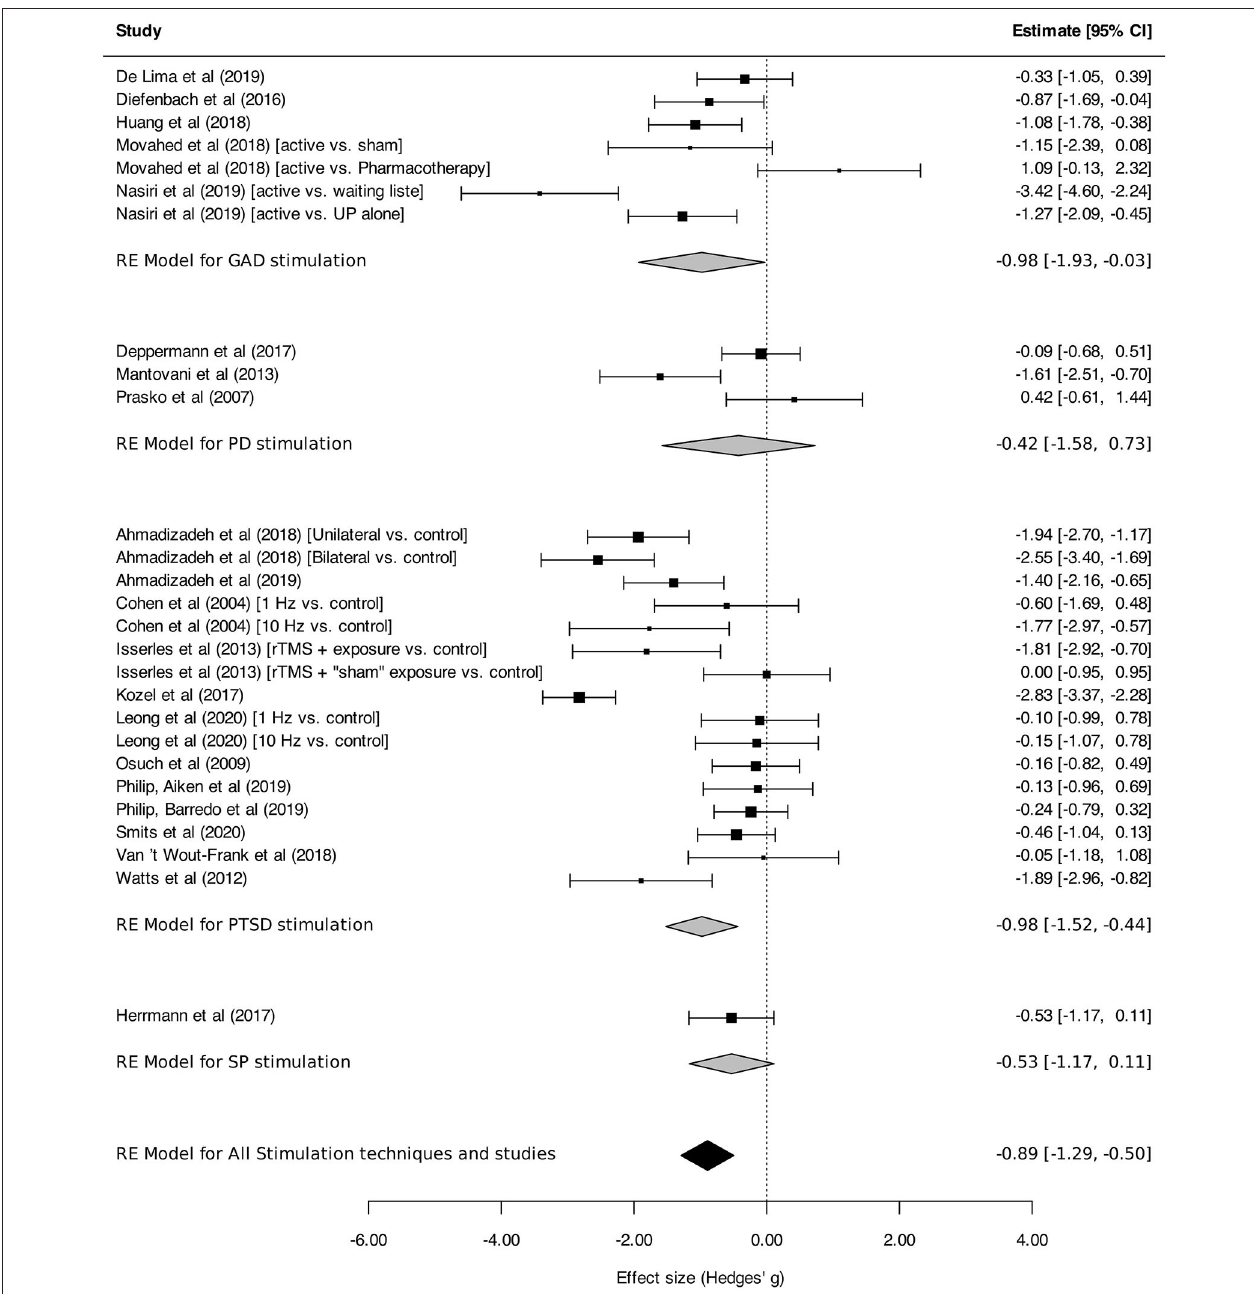
FIGURE 7 | Change in the severity of anxiety, stressor-related disorders, assessed by disorder-specific scale. Statistics: GAD: heterogeneity Sigma1 2 = 0.19, Sigma2 2 = 1.13; Q(df = 6) = 31.04, p < 0.0001; I 2 = 86%; test for overall effect: Z = − 2.02 ( p = 0.04); PD: heterogeneity Sigma1 2 = 0.42; Sigma2 2 = 0.42; Q(df = 2) = 10.22, p = 0.006; I 2 = 82%; test for overall effect: Z = − 0.72 ( p = 0.47); PTSD: heterogeneity Sigma1 2 = 0.51; Sigma2 2 = 0.32; Q(df = 15) = 103.78, p < 0.0001; I 2 = 83%; test for overall effect: Z = − 3.52 ( p = 0.0004); SP: heterogeneity : not applicable; test for overall effect: Z = − 1.63 ( p = 0.10); Total: heterogeneity Sigma1 2 = 0.25, Sigma2 2 = 0.57 ; Q(df = 26) = 153.87, p < 0.0001; I 2 = 83 %; test for overall effect: Z = – 4.40 ( p < 0.0001); test for subgroup differences: F(df1 = 3, df2 = 23) = 0.29, p = 0.83.